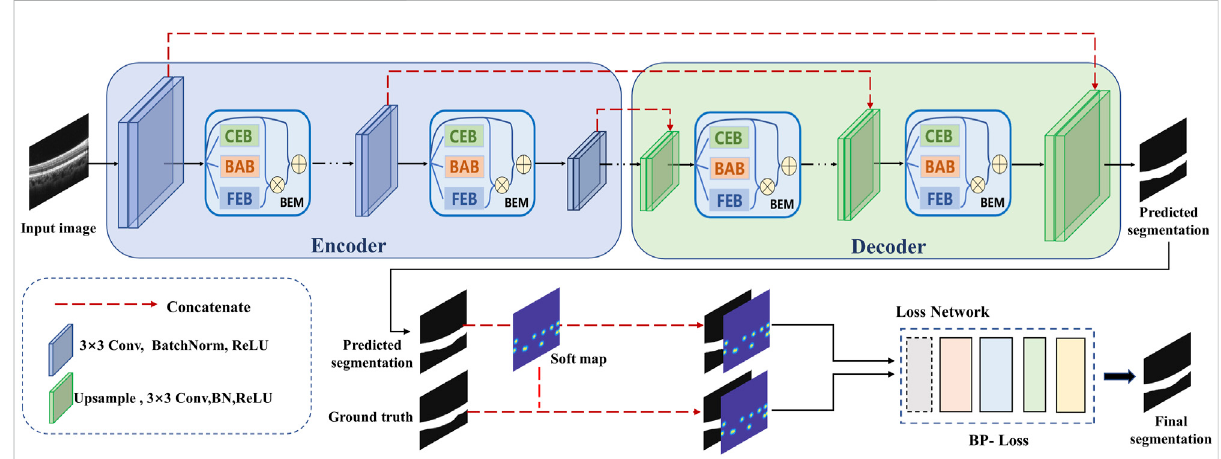
FIGURE 2 An overview of the proposed boundary enhancement framework for choroid segmentation. A novel BEM is incorporated into each encoder/ decoder layer of the proposed framework. In addition, a pre-trained VGG network is utilized to calculate the speci fi c boundary perceptual loss to improve the choroidal boundary segmentation with the guidance of the soft point map generated from ground